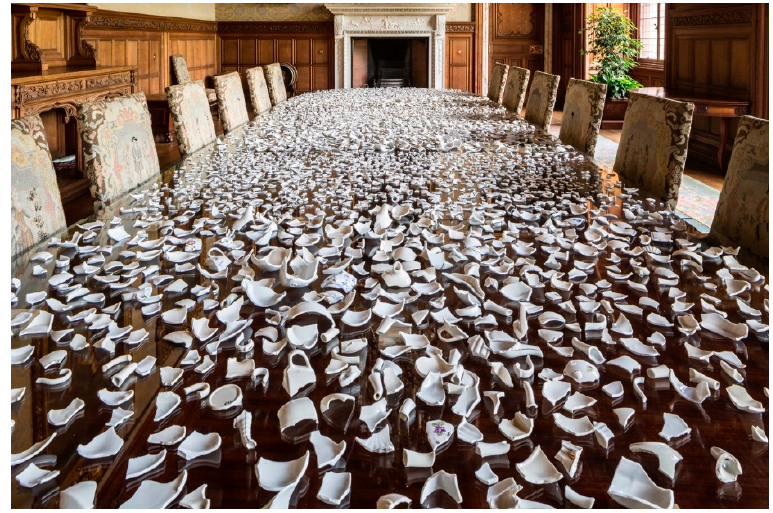
Figure 8. Christine Borland, “The China Harvest”, 2018. 144 ceramic feeder cups blown up in a controlled explosion in Flanders. Image Courtesy of Christine Borland.